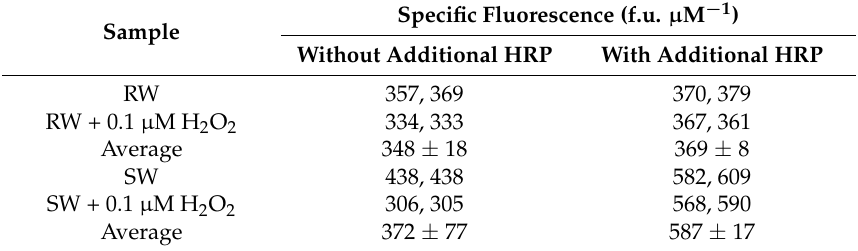
Table 2. Effect of the addition of horseradish peroxidase (HRP) upon the internal additions of H 2 O 2 on the specific fluorescence of